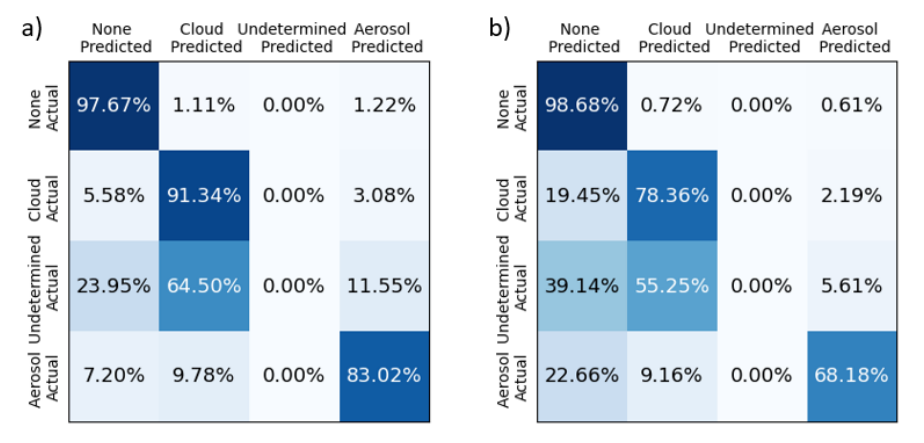
Figure 12. Confusion Matrices for CNN predictions ( x -axis) and actual layer typing from CATS operational data products ( y -axis) from September 2015 during ( a ) Nighttime and ( b )